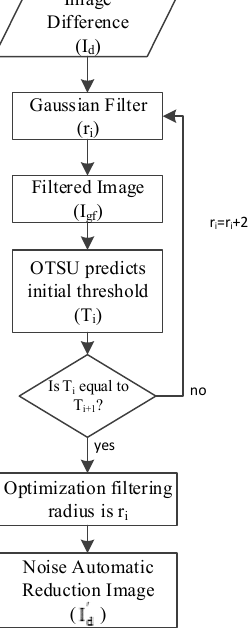
Figure 2. Automatic Noise Reduction method based on Gaussian filter (GF) and OTSU.